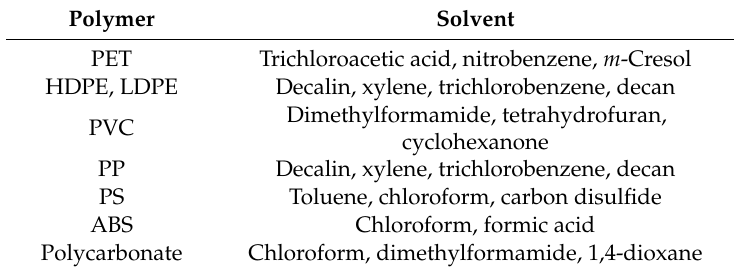
Table 3. Solvents of the main WEEE polymers. Adapted from Braun (2013)